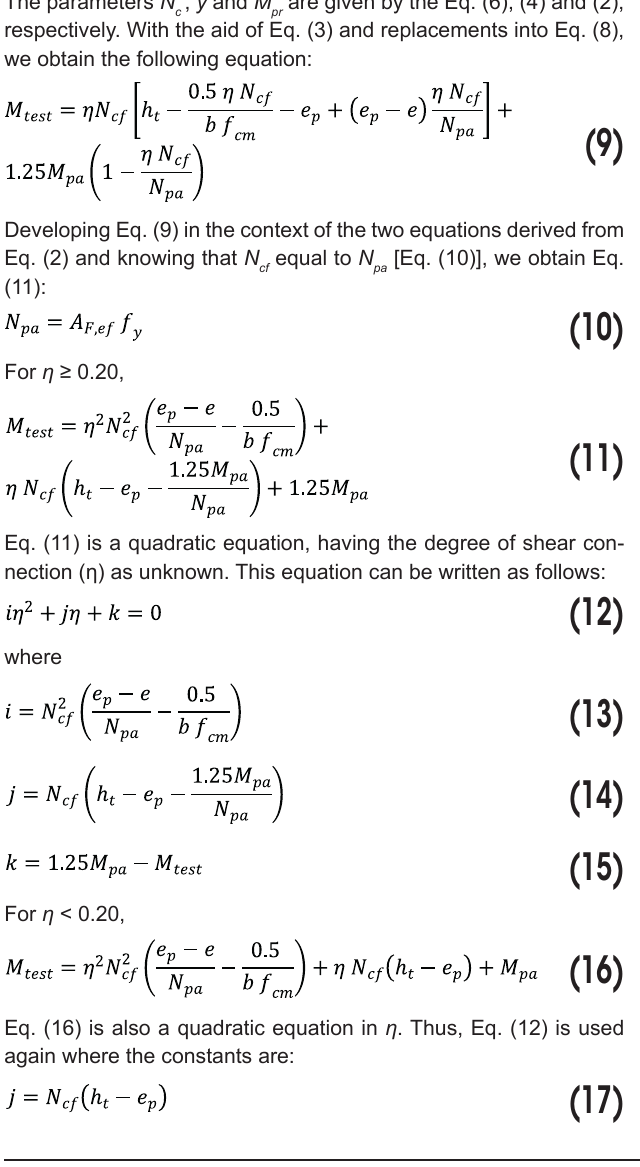
Figure 11 Partial interaction diagram and degree of shear connection h